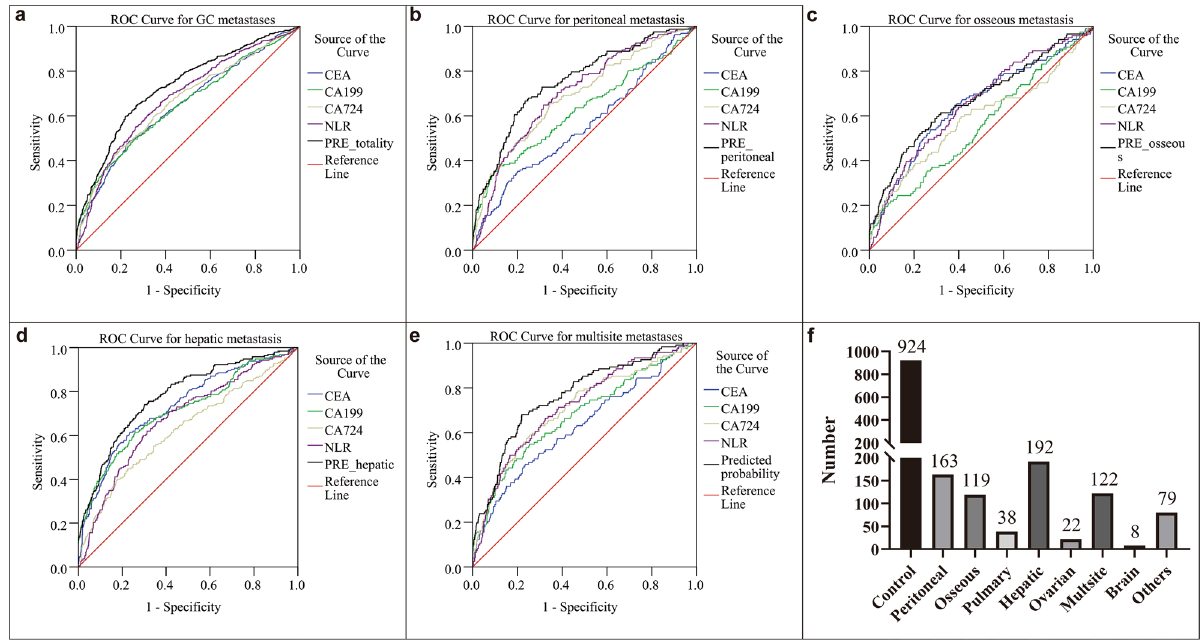
Figure 1. ROC analysis for the prediction of GC metastasis. AUC indicates the diagnostic power of CEA, CA19-9, CA72-4, NLR and prediction probability for total ( a ), peritoneal ( b ), hepatic ( d ), osseous ( c ) and multisite metastasis ( e ). Cases of control group and different sites of metastases ( f ). PRE, prediction probability that was obtained by binary logistic regression of CEA, CA199, CA724 and NLR.